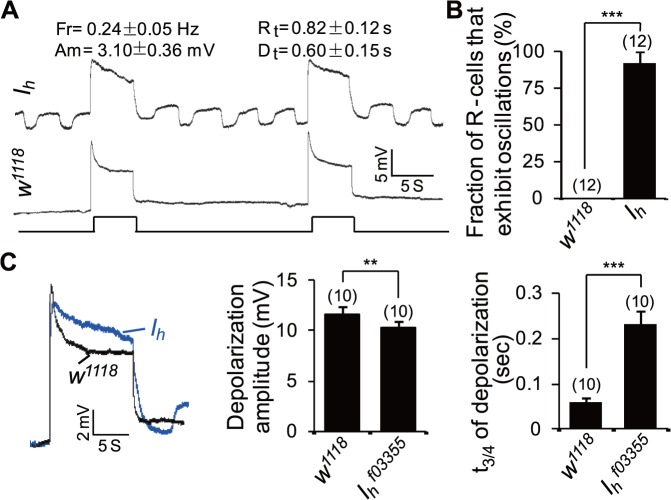

I
h mutant photoreceptors undergo rhythmic depolarization without light stimulation.(A) Intracellular recording traces of wild-type and I
h mutant photoreceptors. For intracellular recording traces, event markers represent 5-s orange light pulses, and scale bars are 5 mV. Measurements of the amplitude (Am), frequency (Fr), rise time (Rt), and decay time (Dt) of rhythmic depolarization are provided at the top. (B) The fraction of photoreceptors (R-cells) that exhibit oscillation phenotype. The numbers of photoreceptors recorded for each genotype are listed. (C) Measurement of the amplitude of light-induced depolarization (middle) and the time (t3/4) required for a 3/4 recovery from the responses upon stimulation cessation (right). n = 10.